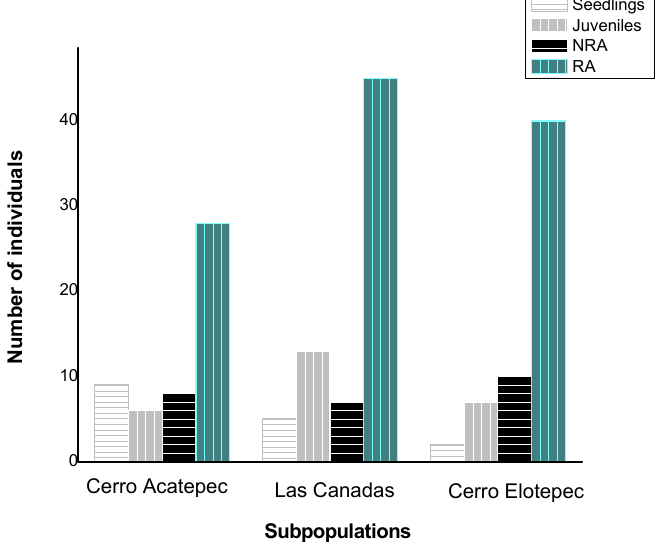
Figure 8. Age and sex population structure of three subpopulations of Ixtaczoquitlán, Veracruz.